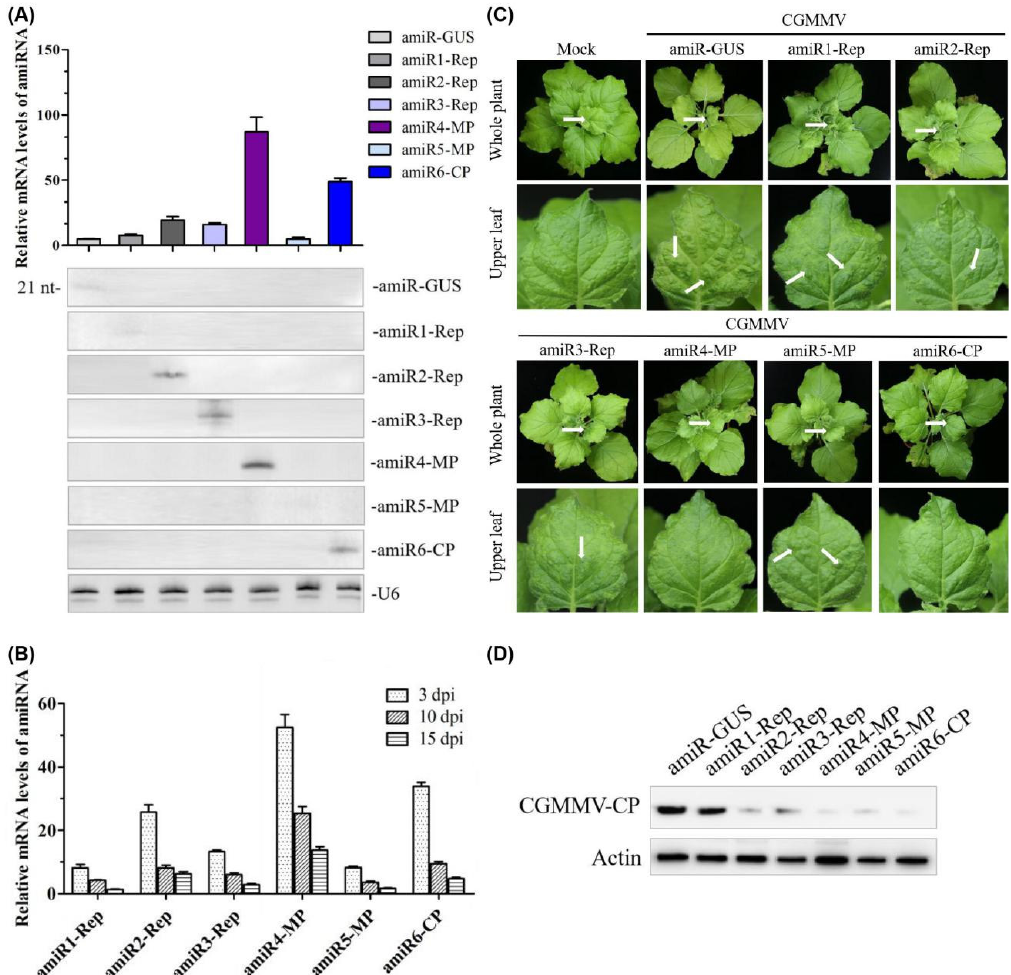
Figure 3. Functional analysis of the anti-CGMMV amiRNA in Nicotiana benthamiana . ( A ) amiRNA expression level detected by qRT-PCR (upper panel) and Northern blot hybridization (lower panel); from left to right in upper and lower panels: amiR-GUS, amiR1-Rep, amiR2-Rep, amiR3-Rep, amiR4-MP, amiR5-MP, and amiR6-CP. RNA isolated from agroinfiltrated leaves at 3 dpi. Each biological replicate represents a pool of two agroinfiltrated leaves from the same plant. U6 hybridization serves as a Northern blot loading control. ( B ) Relative expression of amiR1–amiR6 at 3, 10, and 15 dpi in CGMMV-infected N. benthamiana plants. Error bars represent the mean of three biological replicates ± standard deviation (SD). ( C ) Photographs of CGMMV-infected whole plants and upper leaves at 20 dpi. Characteristic symptoms of CGMMV-induced mild mottle and mosaic are indicated with white arrows shown in upper leaves, as shown below. White arrows on whole plants indicate the upper leaves. ( D ) Western blot hybridization detection of CGMMV coat protein (17.4 kDa) accumulation in infected upper leaves at 20 dpi. dpi, days post ‐ inoculation. amiR1 ‐ Rep, amiR2 ‐ Rep, and amiR3 ‐ Rep mean the amiRNA targeted three different regions of the Rep gene of CGMMV, respectively; amiR4 ‐ MP and amiR5 ‐ MP mean the amiRNA targeted two different regions of the MP gene of CGMMV, respectively; amiR6 ‐ CP means the amiRNA targeted the CP gene of CGMMV; amiR ‐ GUS means the amiRNA targeted the GUS gene.